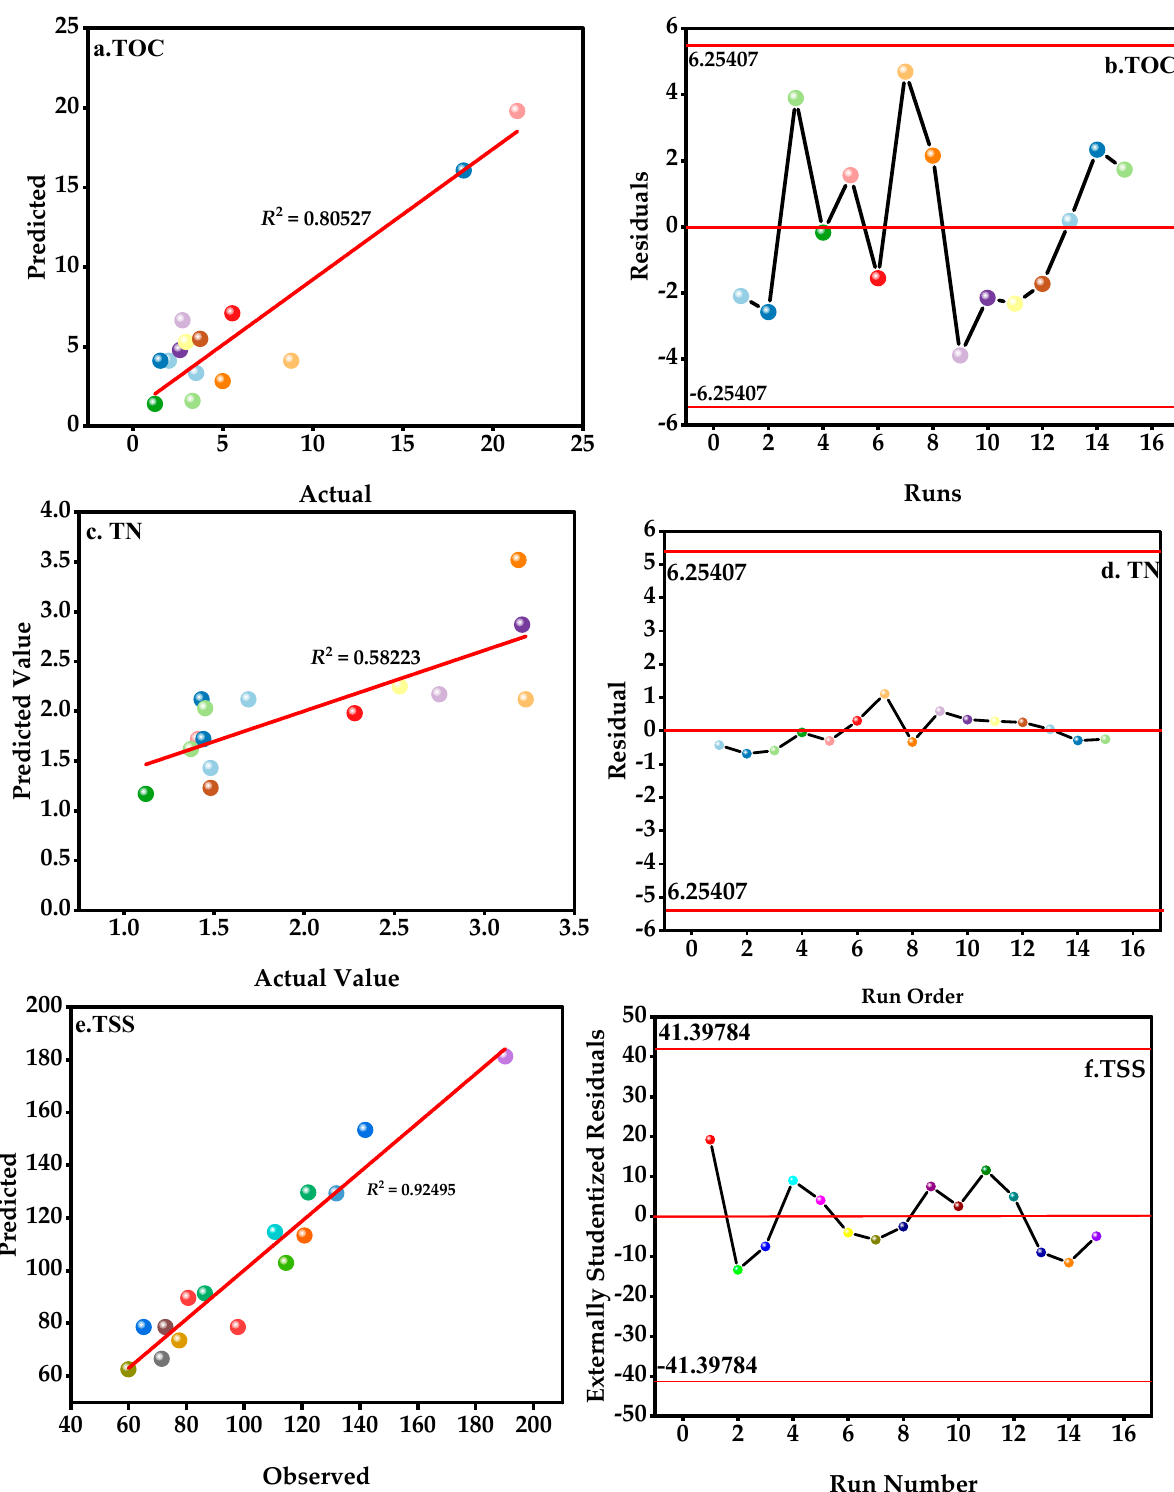
Figure 3. Predicted vs. residual values plots for TOC ( a , b ), TN ( c , d ), and TSS ( e , f )